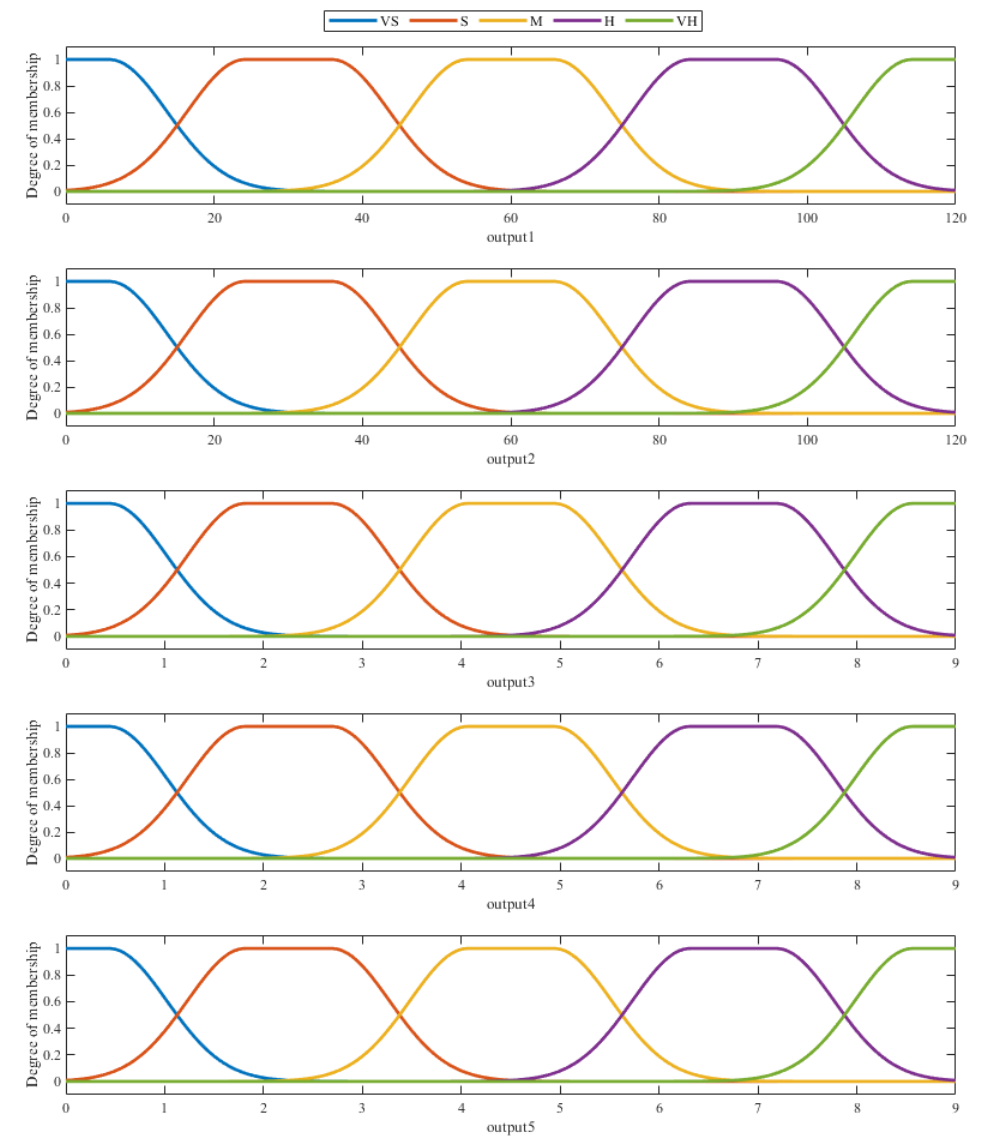
Figure 5. Output membership function for Scenario